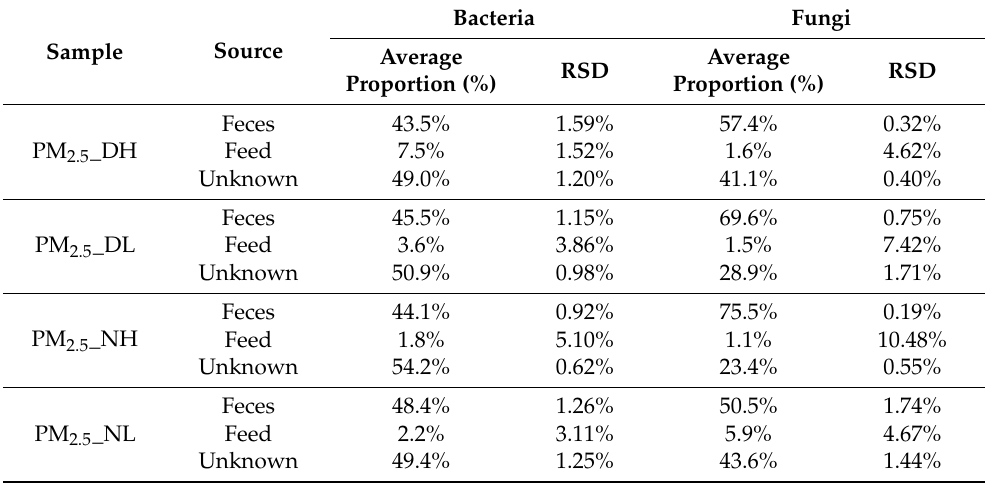
Figure 5. Traceability analysis of bacteria ( a ) and fungi ( b ) by SourceTracker method. Table 6. Relative Standard Deviation Analysis of SourceTracker Results after Five Independent Runs of Select Samples.